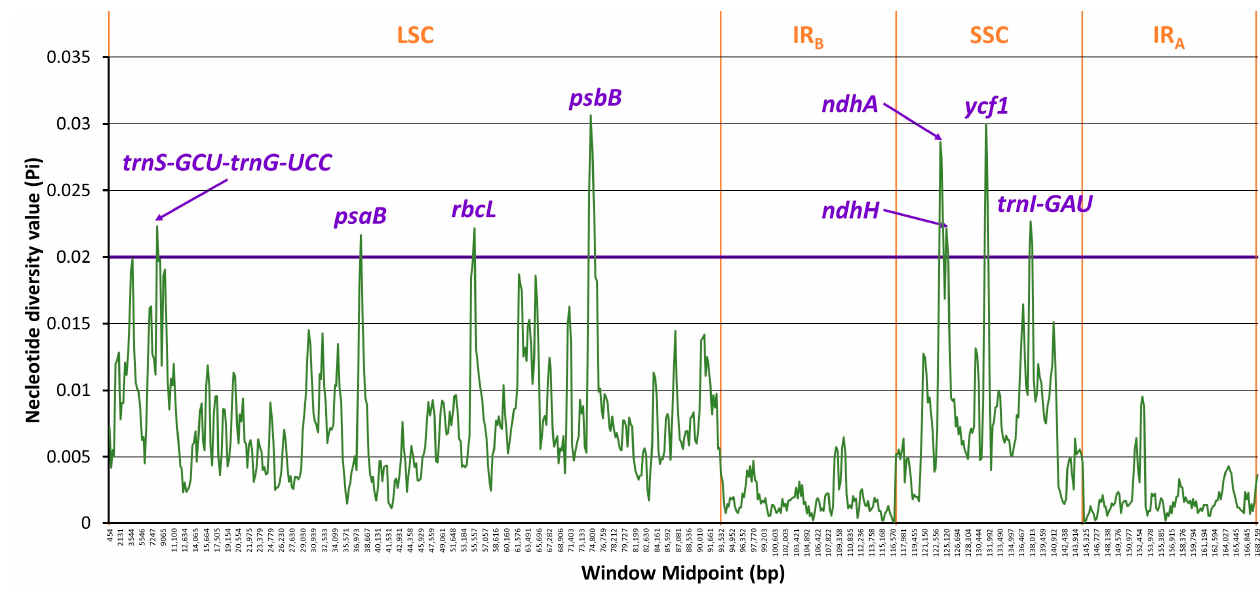
Figure 7. Sliding window analysis of eighteen Smilacaceae species revealing candidates of divergence hotspots. Threshold value of Pi = 0.02.